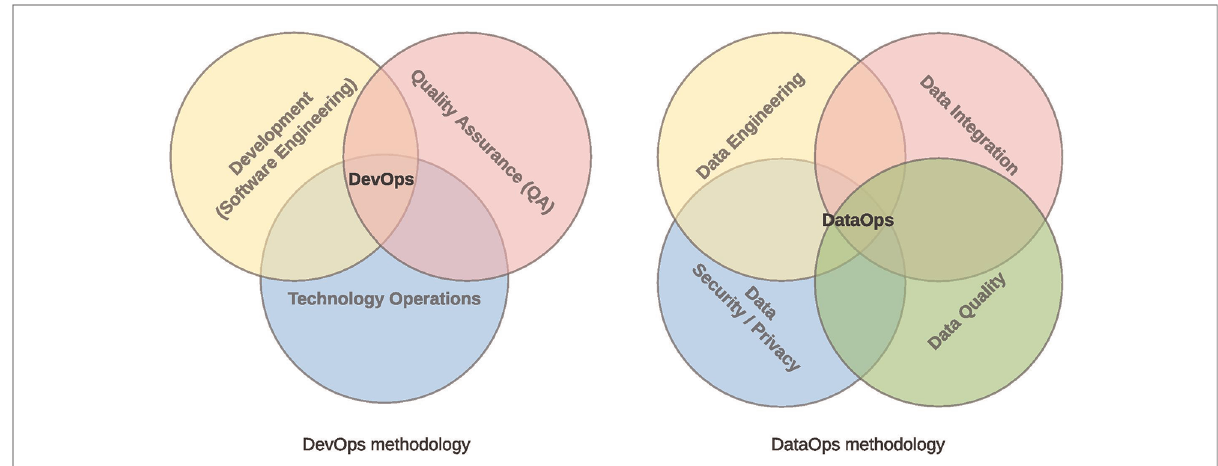
FIGURE 1 DevOps (16) and DataOps in the enterprise